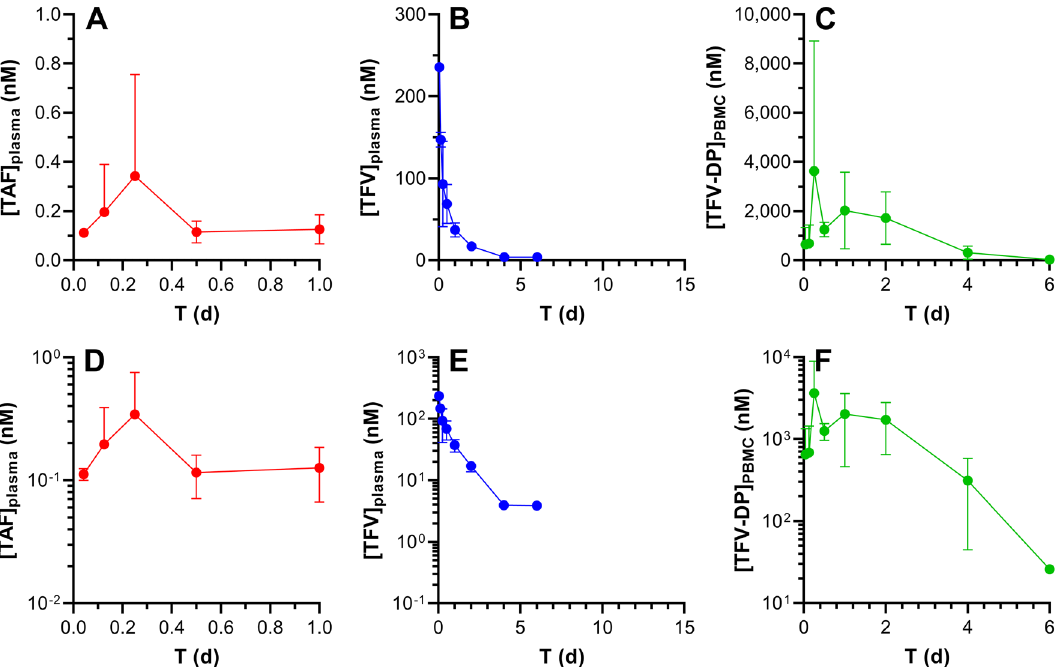
Figure 3. Subcutaneous TAF injection in C57BL/6 J mice results in different pharmacokinetics across the three key analytes. The data are shown as linear ( A – C ) and semilog ( D – F ) plots and all concentration units are represented in nanomolar (nM) for ease of comparison. Concentration–time profiles of plasma TAF ( A and D ; red circles), plasma TFV ( B and E ; blue circles), and PMBC TFV-DP ( C and F ; green circles) are shown as means ± SD ( N = 4 per group). The assay LLOQs are: TAF, 0.06 nM (0.03 ng mL -1 ); TFV, 3.5 nM (1 ng mL -1 );